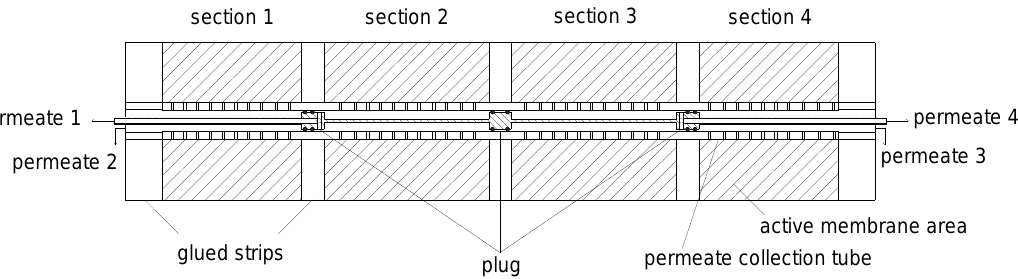
Figure 6. Axial cross-section of a SWM sectioned by glued strips in the permeate pocket, and the plug system integrated into the sectioned SWM. Shaded areas mark the active filtration area.